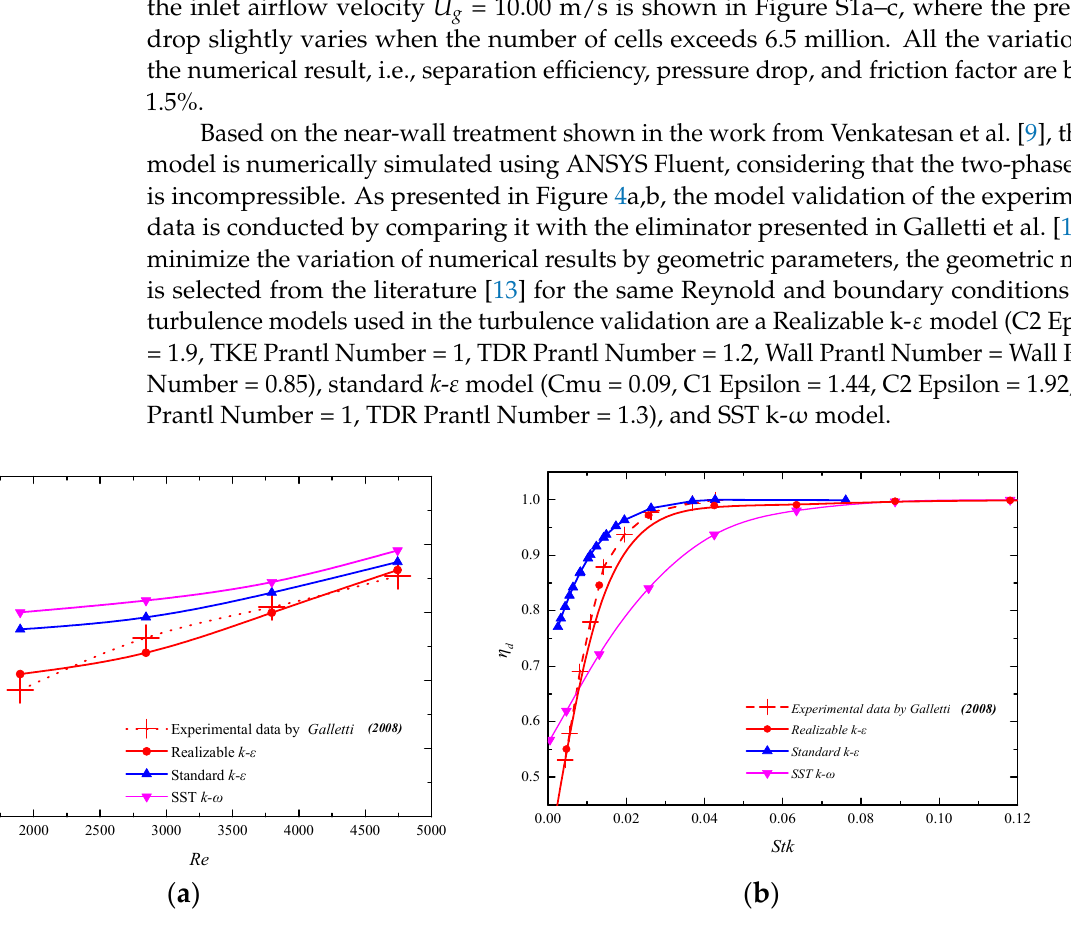
Figure 4. Model validation with the experimental data: ( a ) validation of friction factor and ( b ) validation of separation efficiency.